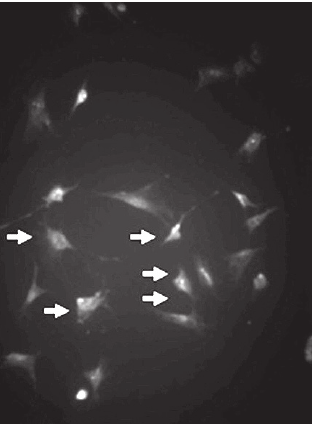
Fig. 1 - Cultura de células mesenquimais (flechas) identificadas pelo anticorpo anti-vimentina (Imunofluorescência, x